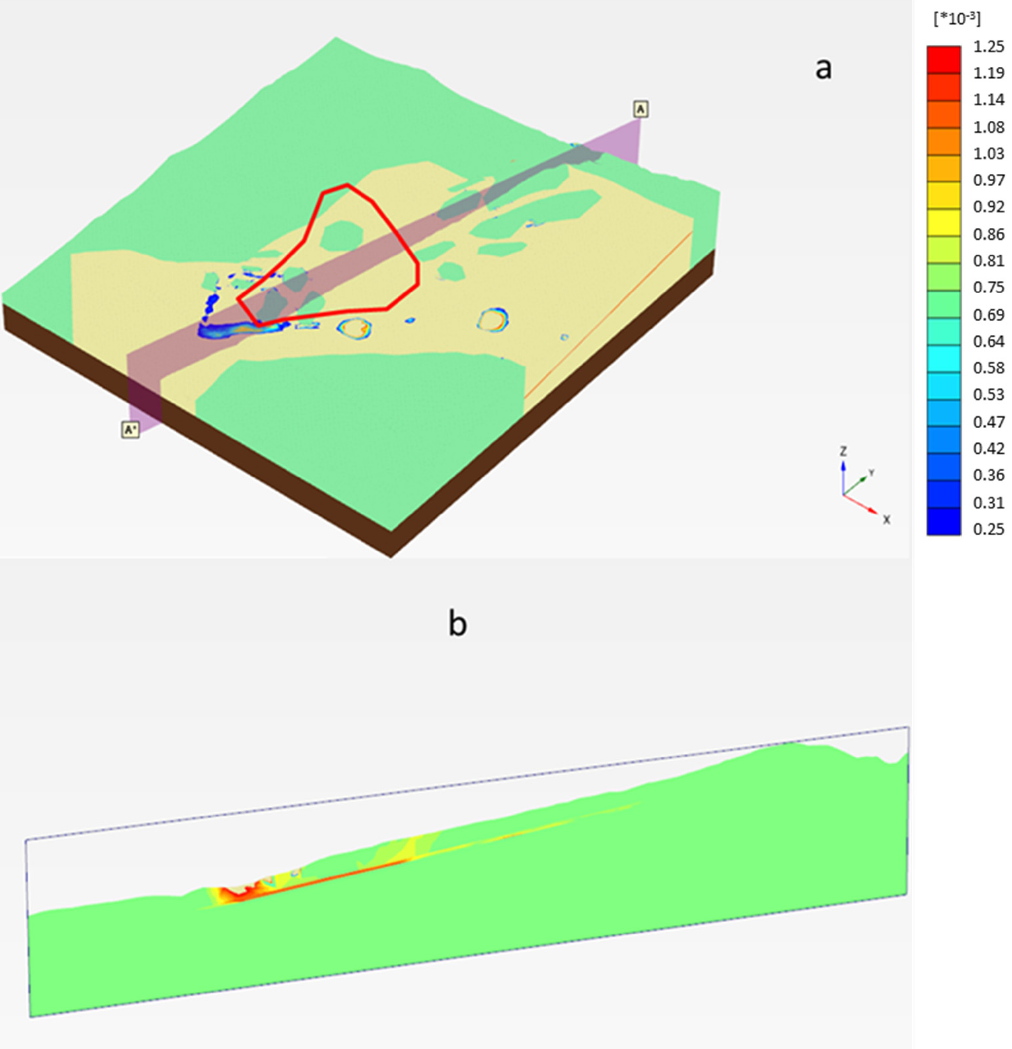
Figure 12. Contours of the deviatoric strains calculated ( a ) and the cross − section of the landslide area ( b ).